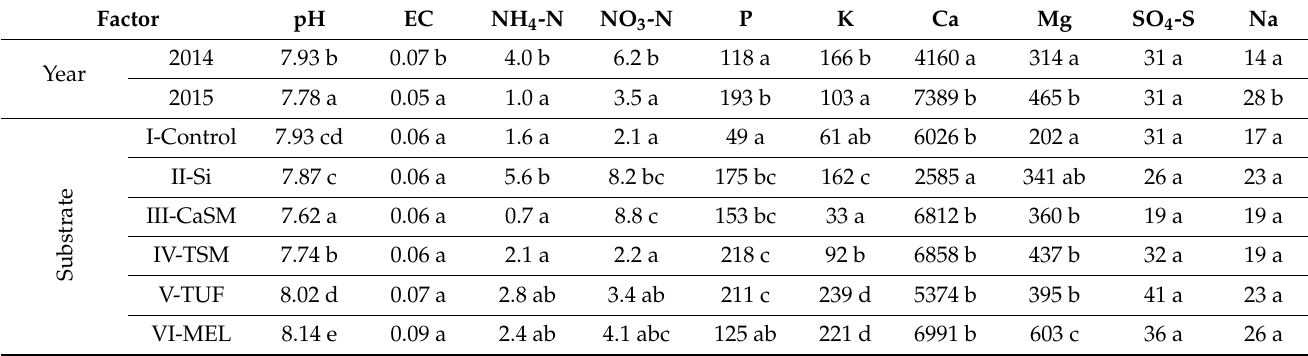
Table 7. Soil reaction (pH H2O ), salts concentration (EC—mS cm − 1 ), macronutrients (mg dm − 3 ), and trace elements (mg kg − 1 ) content estimated after one- or two-year growth of Sedum acre L. in the substrates. Factor pH EC NH 4 -N NO 3 -N